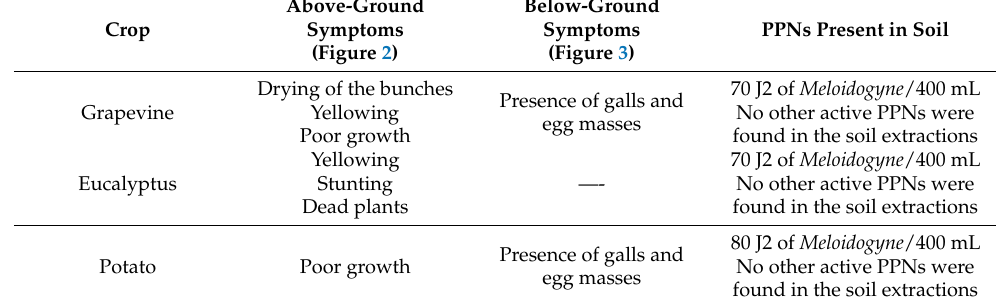
Table 2. Symptoms observed in plants infected with Meloidogyne hapla and plant parasitic nematodes (PPNs) found in soil.